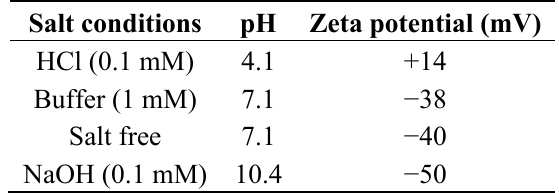
Table 1. Mean zeta potentials of bare SBs at various